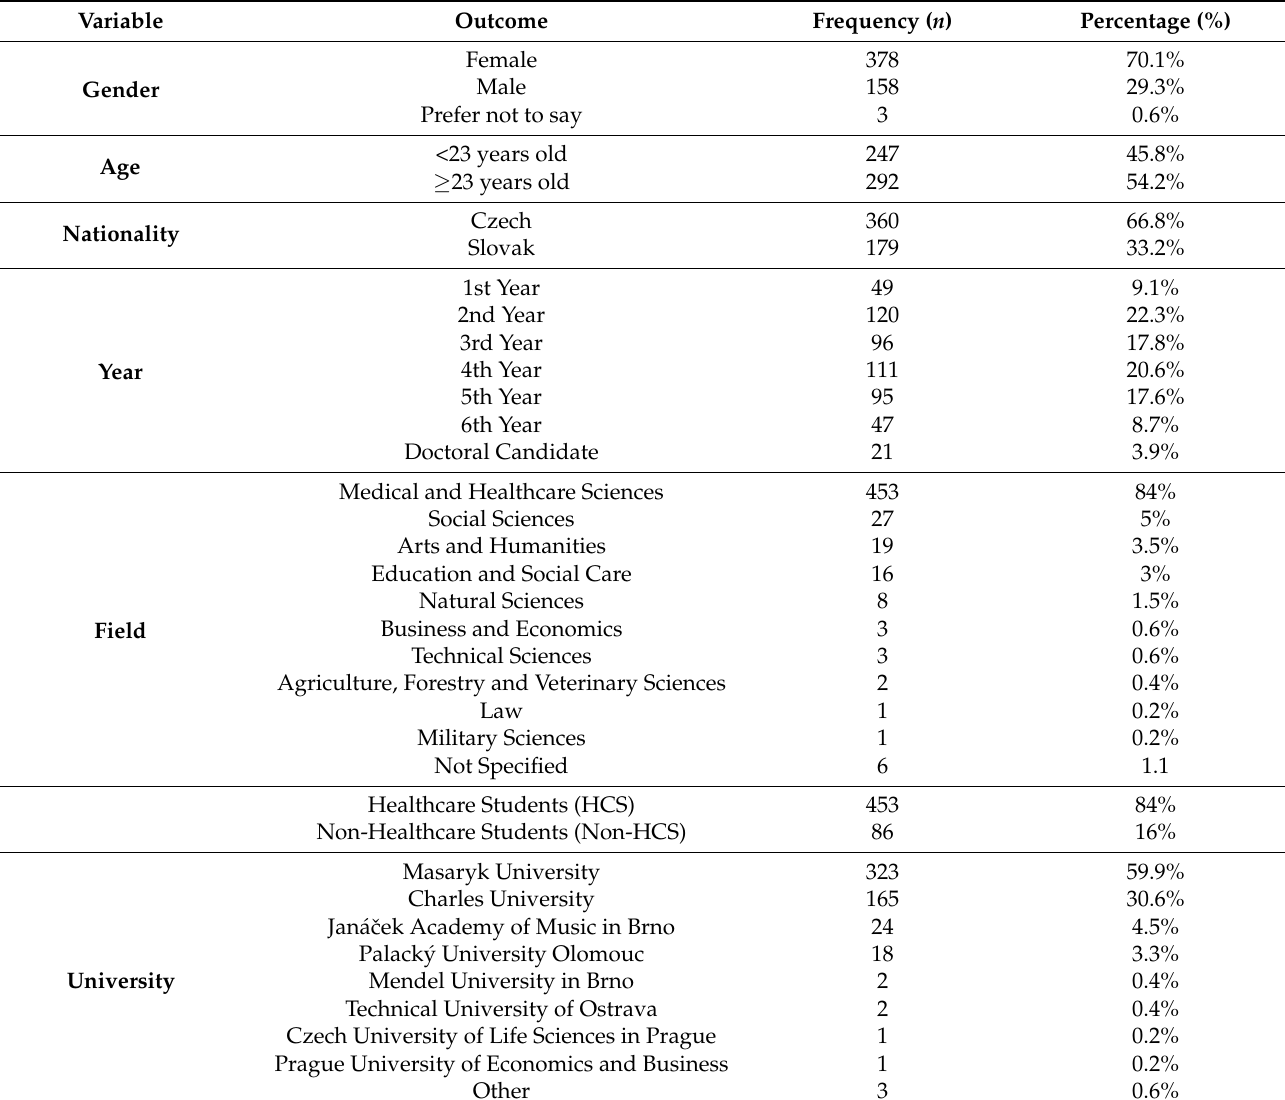
No significant differences between females and males were found in terms of the number of doses, duration between doses, and vaccine type. (Table 2). Table 1. Demographic characteristics of young adults (18–30 years old) receiving mRNA-based COVID-19 vaccines, Czech Republic, April–June 2021 ( n = 539).